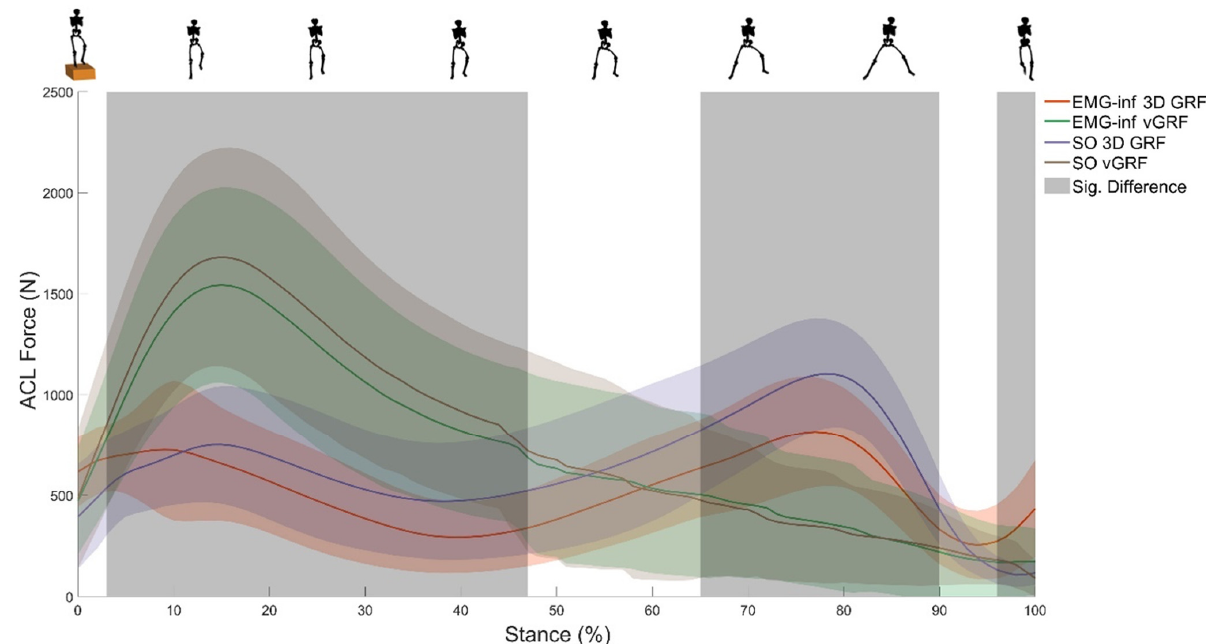
Figure 1. Ensemble average (±1 standard deviation) total ACL force over the stance phase of the barefoot drop–land–jump estimated via four modelling approaches: EMG-informed + 3D GRF (red line); Static optimisation + 3D GRF (purple line); EMG-informed + vertical GRF (green line); Static Optimisation + vertical GRF (brown line). The grey-shaded region displays the areas of significant statistical differences using one-way repeated measures ANOVA applied through statistical parametric mapping. vGRF, vertical ground reaction force; EMG-inf, EMG-informed; SO, static optimisation.